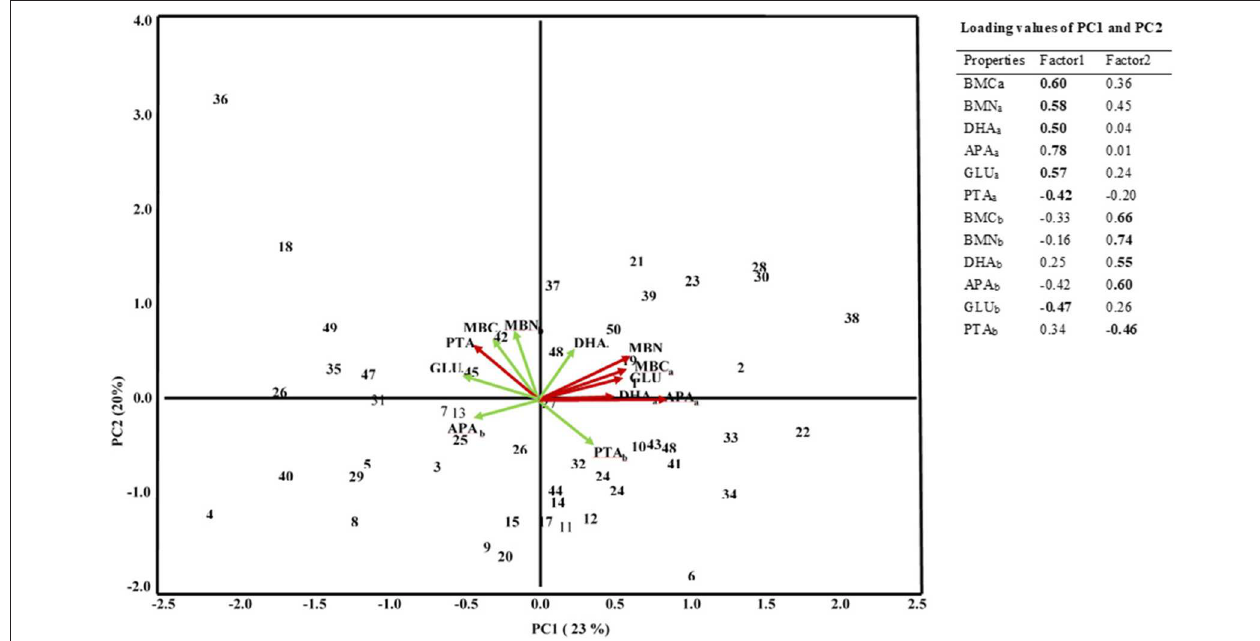
FIGURE 2 | PCA of soil biochemical properties in a rewetted peatland. MBC, microbial biomass C; MBN, Microbial biomass N; DHA, Dehydrogenase; APA, Acid phosphatase; GLU, β -Glucosidase; PTA, Protease. The subscript “a” and “b” represent samples of 0–10 and 10–20cm depths, respectively. Numbers in the Figure stand for the number of sampling grid